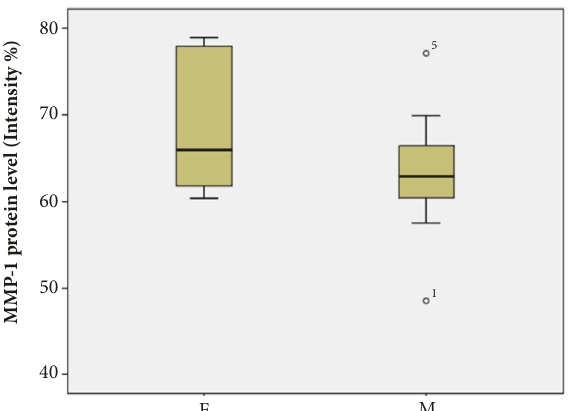
Figure 5: Boxplot depiction of MMP-1 values of male and female symptomatic patients (P > .05).